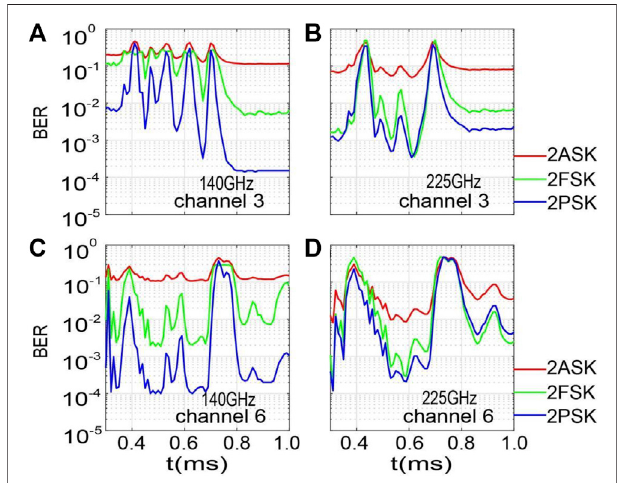
FIGURE 4 | The time-varying BER of EHF signals with different modulation methods in the side channels 3 (A,B) and 6 (C,D) of the plasma sheath of a sharp-coned reentry vehicle. Left panels are results of 140 GHz, and right panels are results of 225 GHz.